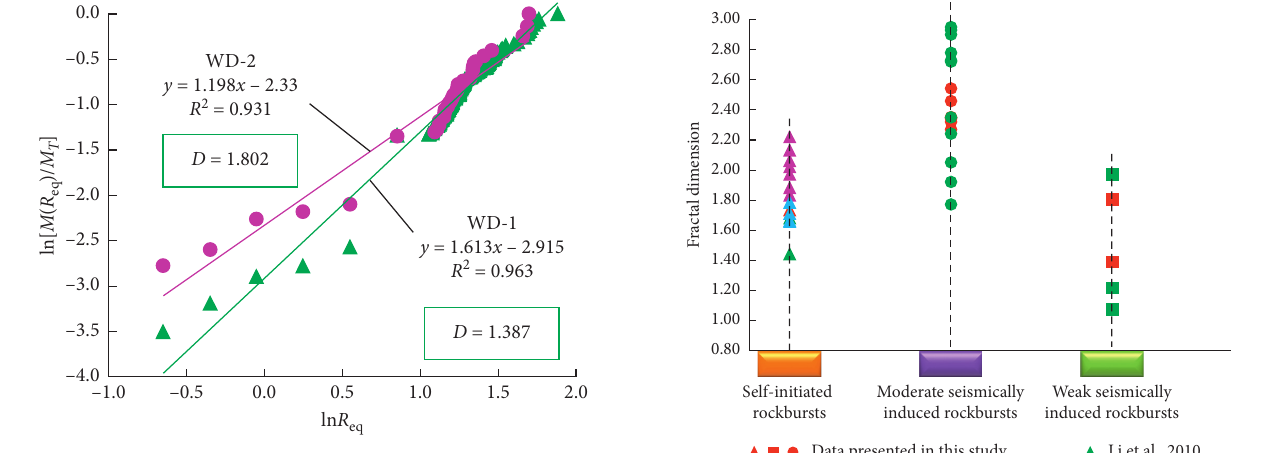
Figure 9: Calculation of fractal dimensions of the weak seismically induced rockbursts.